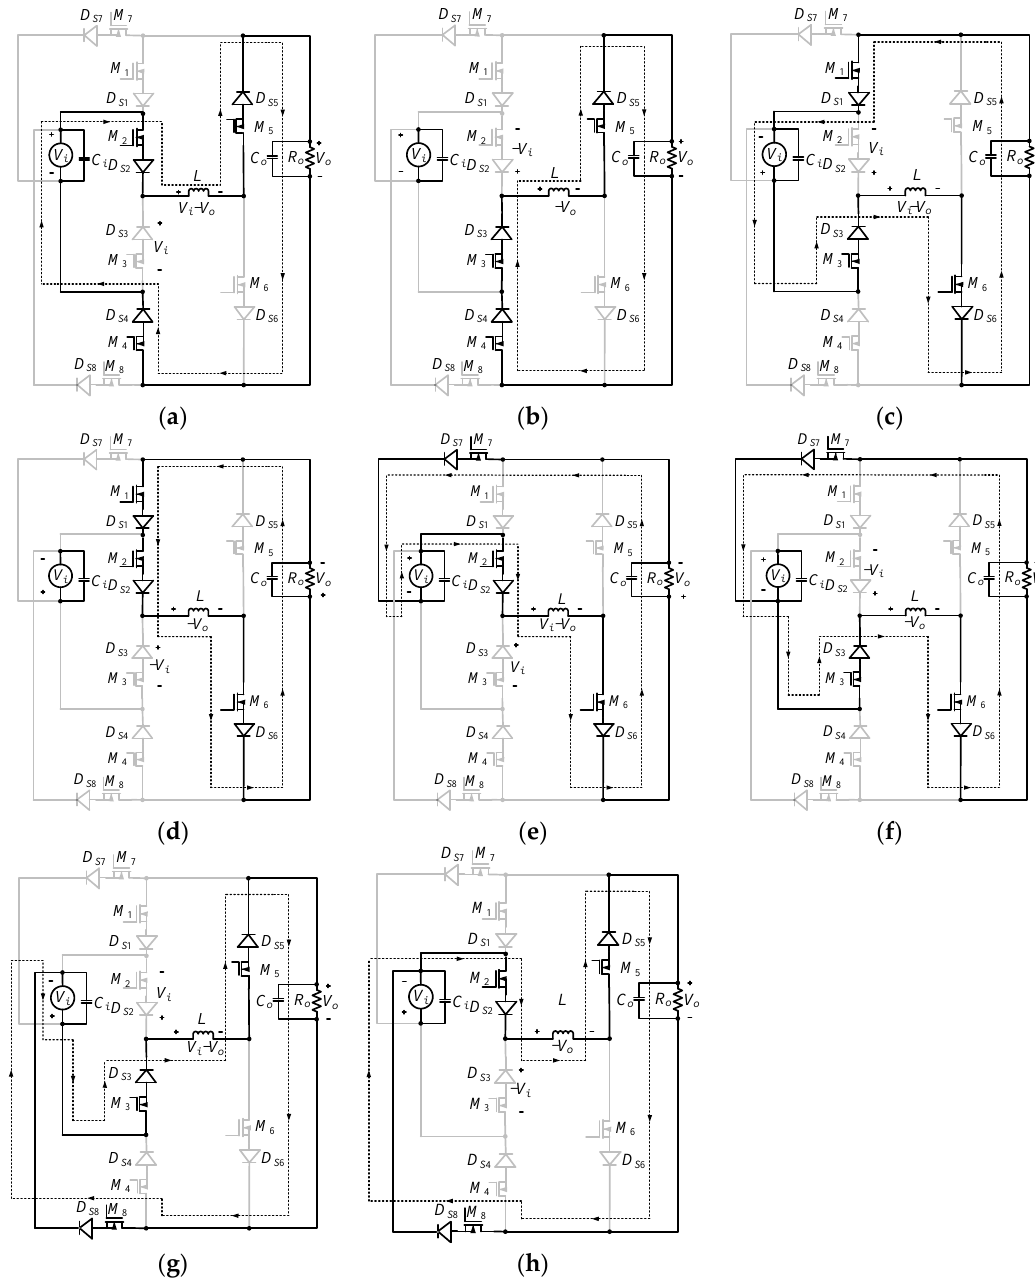
Figure 3. Parts ( a – d ) and ( e – h ) represent the non-inverting and inverting buck operation respectively.